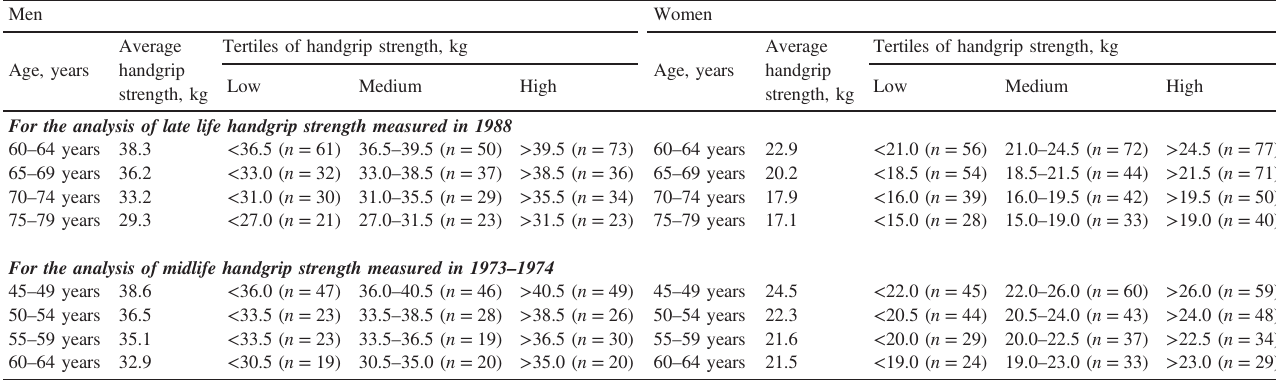
Table 1. Ranges of the tertiles of handgrip strength measured in 1988 or 1973 – 1974 according to age and sex group Men Tertiles of handgrip strength, kg Tertiles of handgrip strength, kg Low Medium High Low strength, kg For the analysis of late life handgrip strength measured in 1988 60 – 64 years